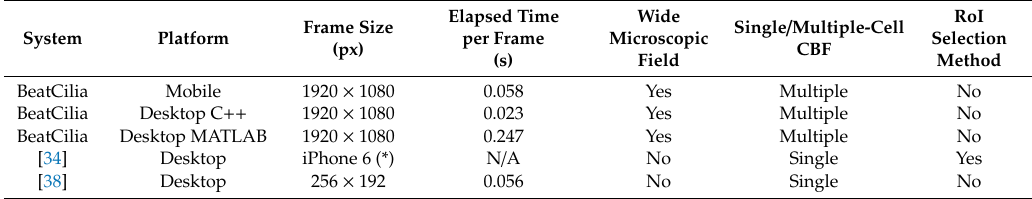
Table 4. Comparison of BeatCilia with the systems proposed in